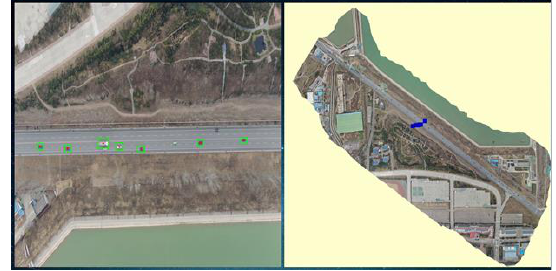
The first two sets experiment show that target recognition and geolocation are robust, but vehicle targets geolocation are unstable with increasing mismatch between keyframes and landmark database when the flight altitude exceeds 200m. The following figure shows the result of vehicle detection and geolocation of 300m flight altitude. It can be found that different classes of vehicle targets could be detected, but the target geolocation effect on the reference image is poor, which seriously deviates from the original position of the target and could not meet the geolocation requirements.